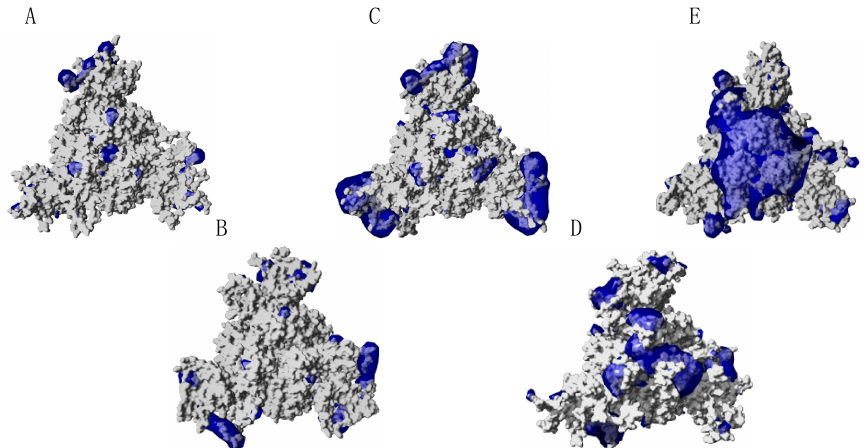
Figure 3. Distribution of the electrostatic potentials calculated with the ESPPME method on the molecular surface of homotrimeric spikes of Wuhan strain ( A ), beta ( β ) variant ( B ), kappa ( κ ) variant ( C ), delta ( δ ) variant ( D ) and omicron (o) variant ( E ) of SARS-CoV-2. Electropositively and electronegatively charged areas are colored blue and red, respectively. Neutral surfaces are white. Note that electropositive patches in the κ , δ and o variants are located, essentially in the region occupied by RBDs.